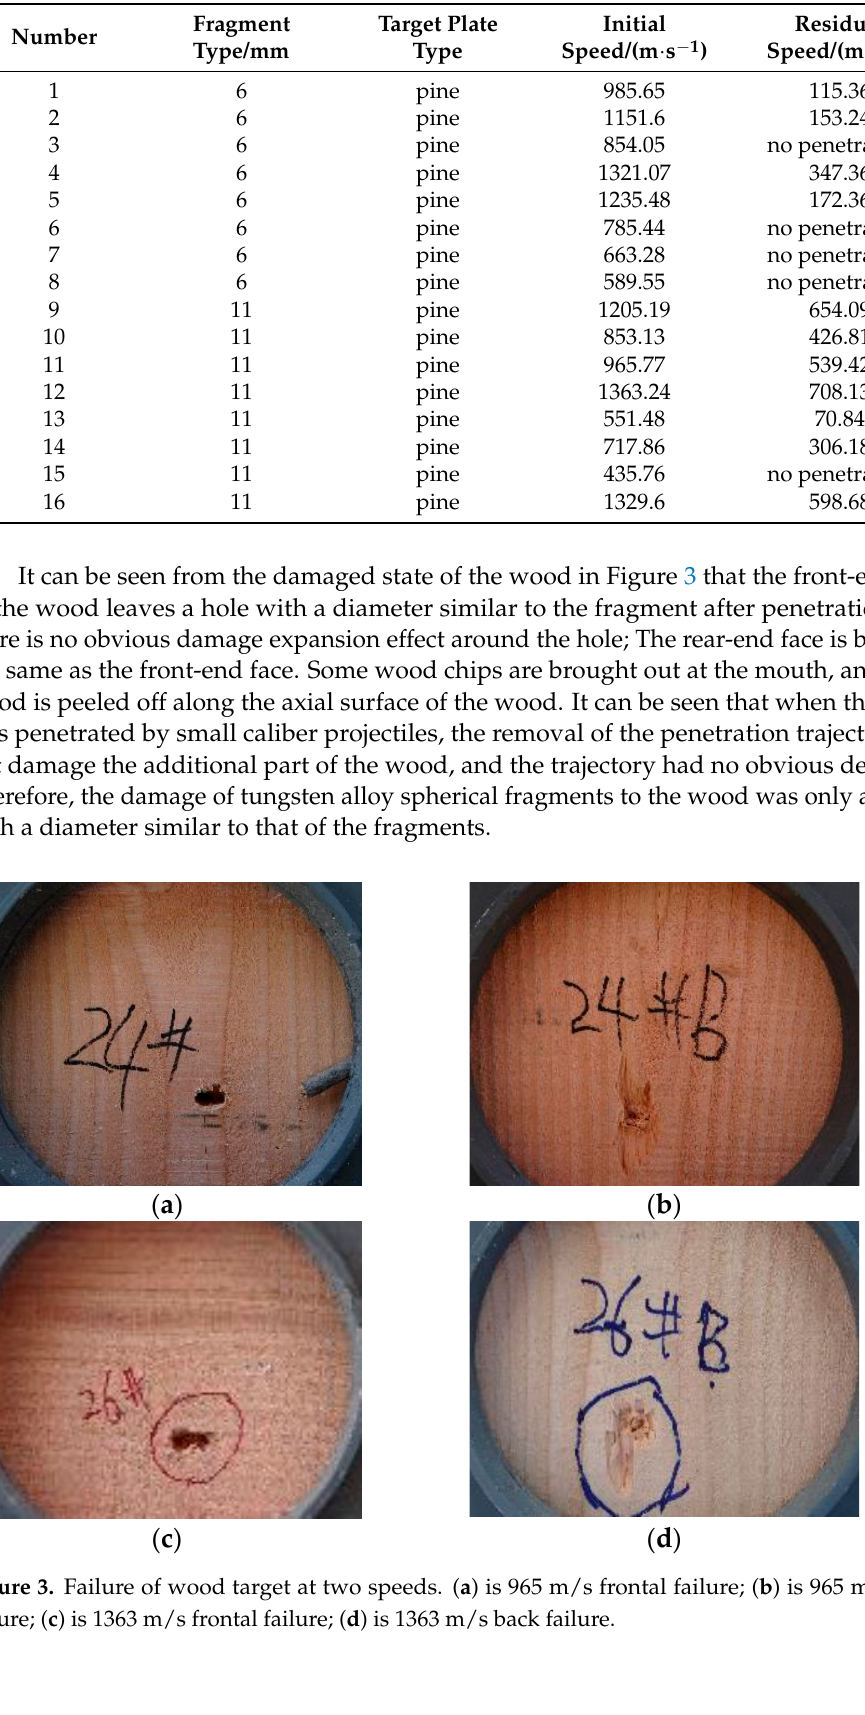
Table 1. Test conditions.